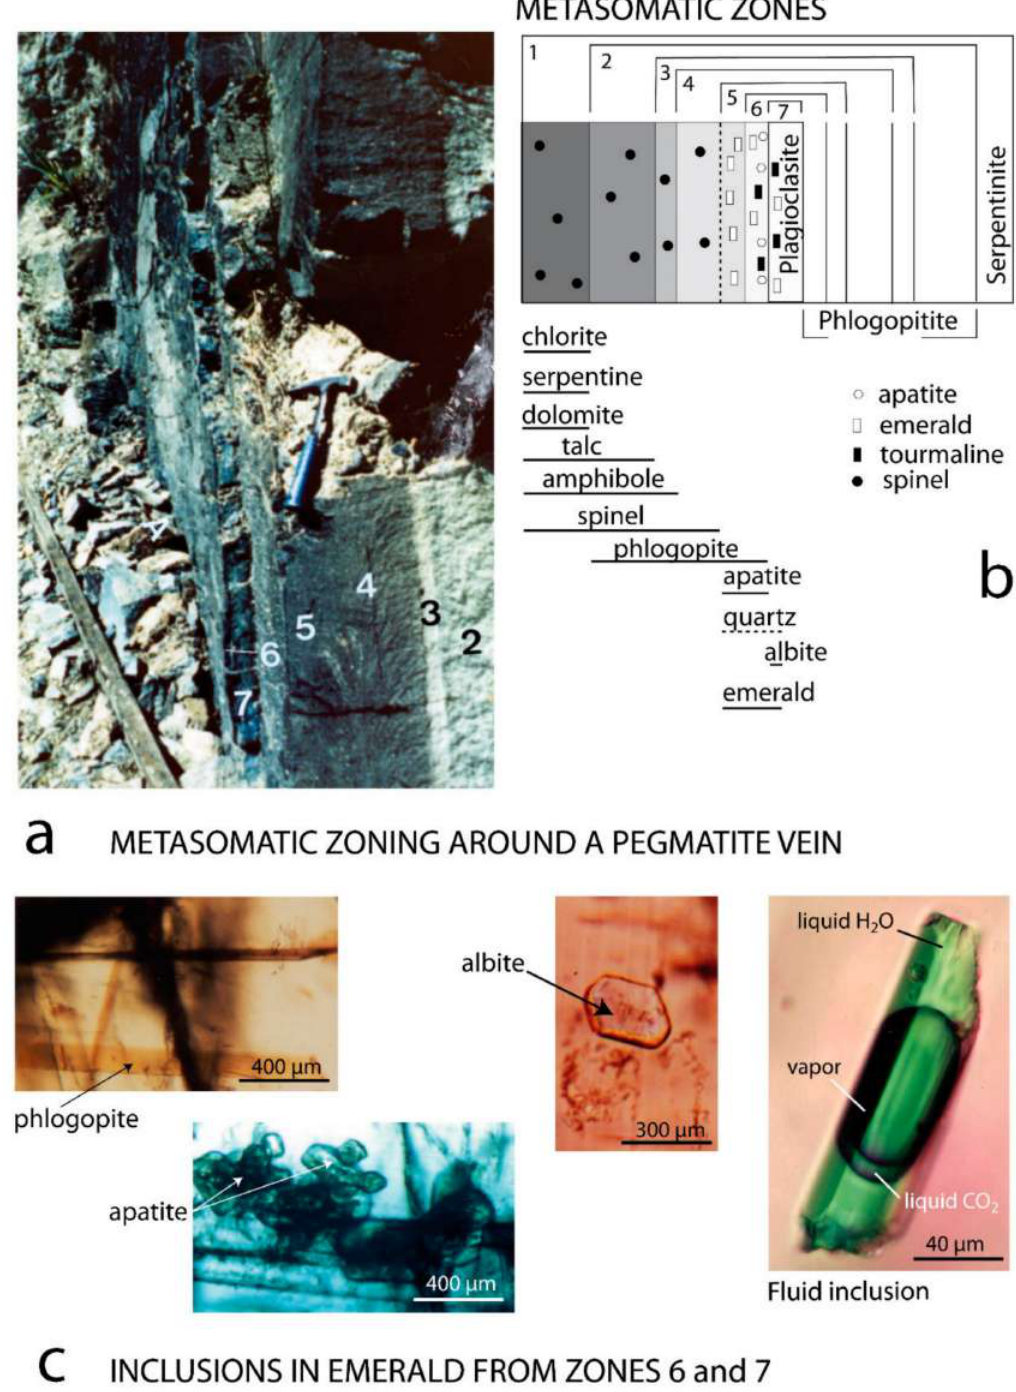
Figure 14. The metasomatism related to fluid circulation between aplopegmatite dikes and mafic-ultramafic rocks: ( a ) Metasomatic column formed by different mineralogical zones (zones 7 to 2) developed around a central pegmatite vein crosscuting serpentinites, Bra ú lia prospecting pit, Carna í ba; ( b ) vein-like metasomatic rocks and their mineralogical composition. The pegmatite is transformed into plagioclasite (zone 7) and the metasomatic rocks consist of six zones, from the desilicated pegmatite to the enclosing serpentinite (zones 6 to 2). Emerald is found in the plagioclasite and in zones 6 (coarse-grained phlogopitite) and 5 (fine-grained phlogopitite). Zone 1 is the protolith formed by the serpentinite (not seen on the photograph); ( c ) solids and fluid inclusion in emeralds from zones 7 and 6 (Photographs: Dietmar Schwarz and Gaston